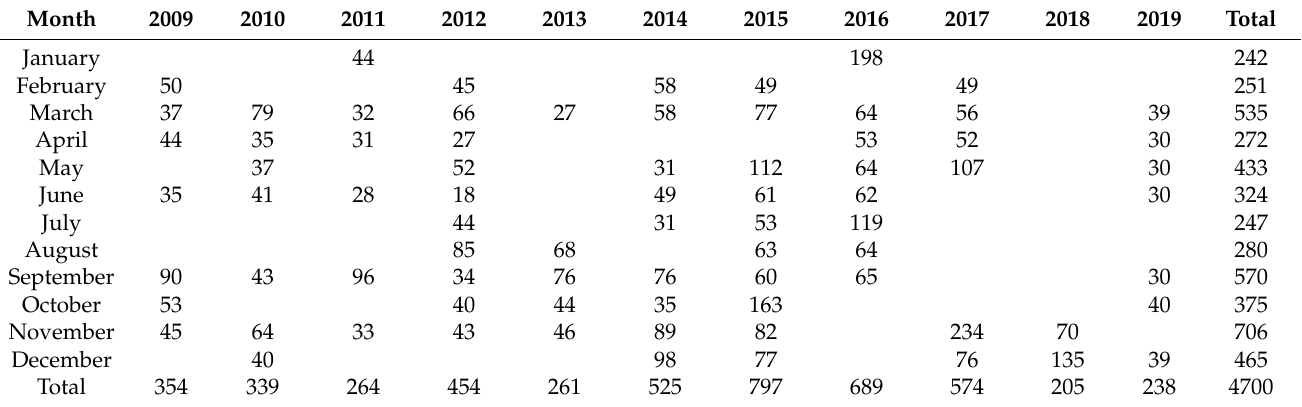
Table 1. Number of fish sampled per month for age reading purposes along the study period.